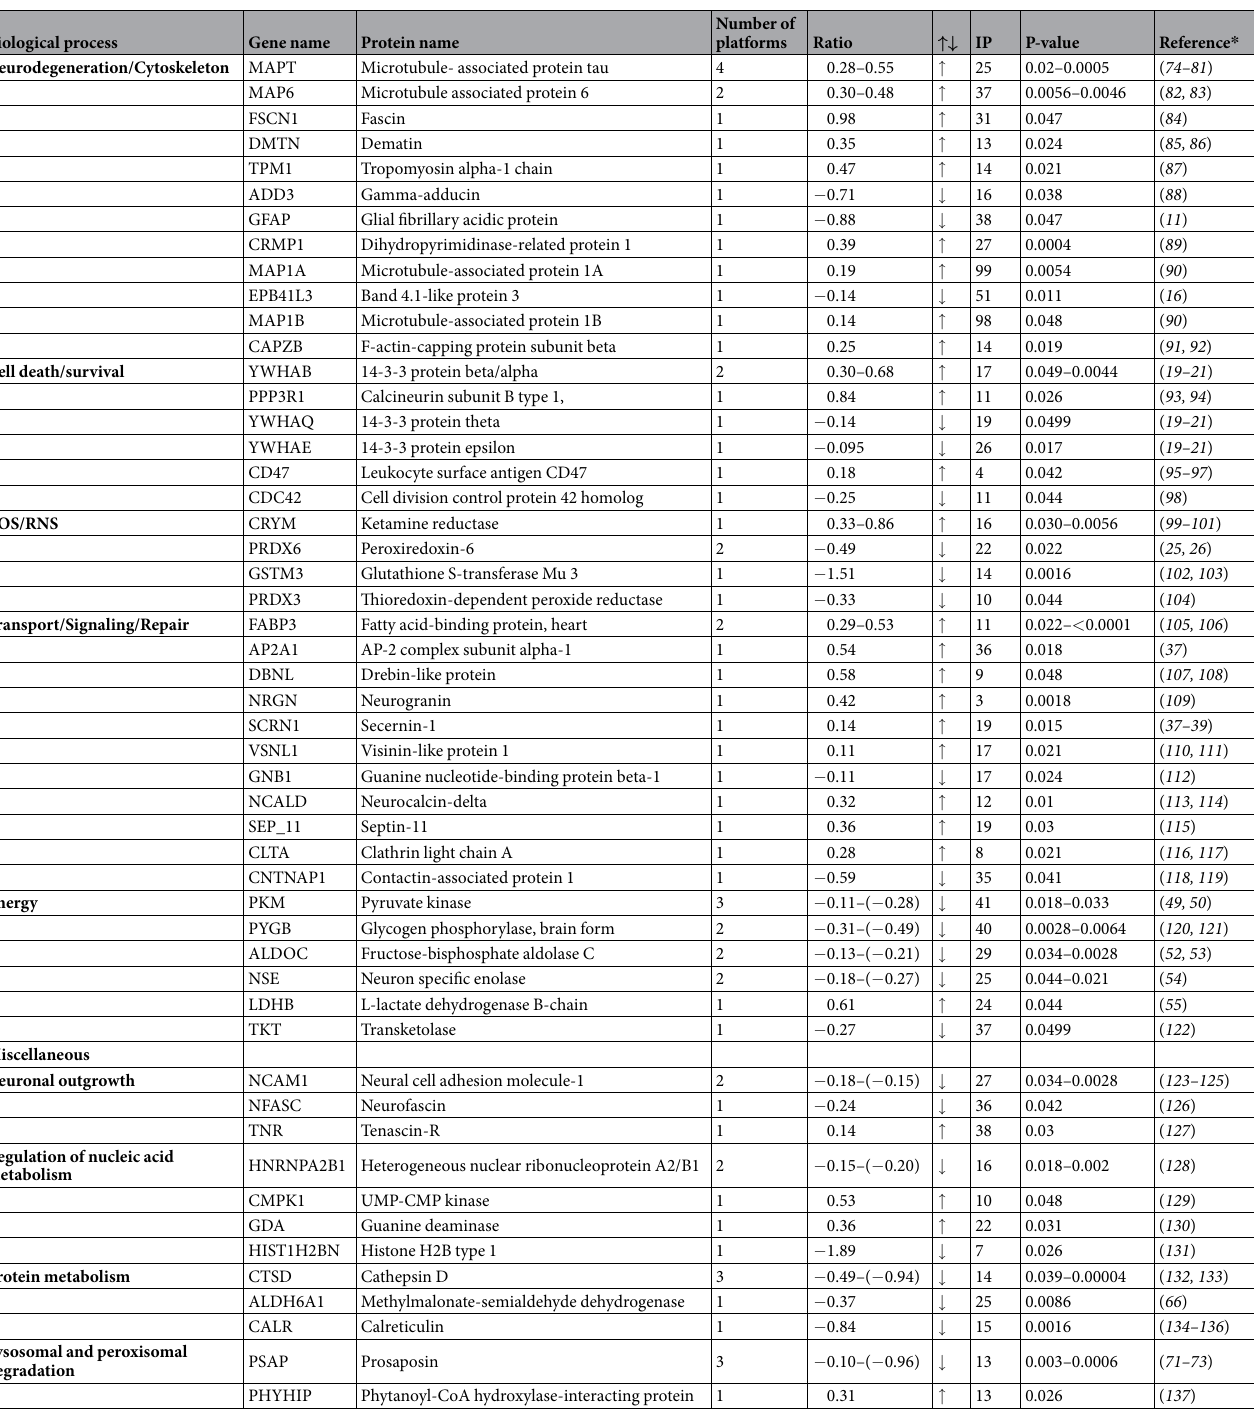
Table 4. Mass spectrometry analysis of brain tissue biopsies from structurally normal-appearing frontal cortex- STUDY B . Significantly up- or downregulated proteins in biopsies from patients with diffuse axonal injury (DAI) in comparison to focal brain injury. IP = Number of identified peptides, ↑↓ = Increased or decreased, * = Reference provided in supplementary